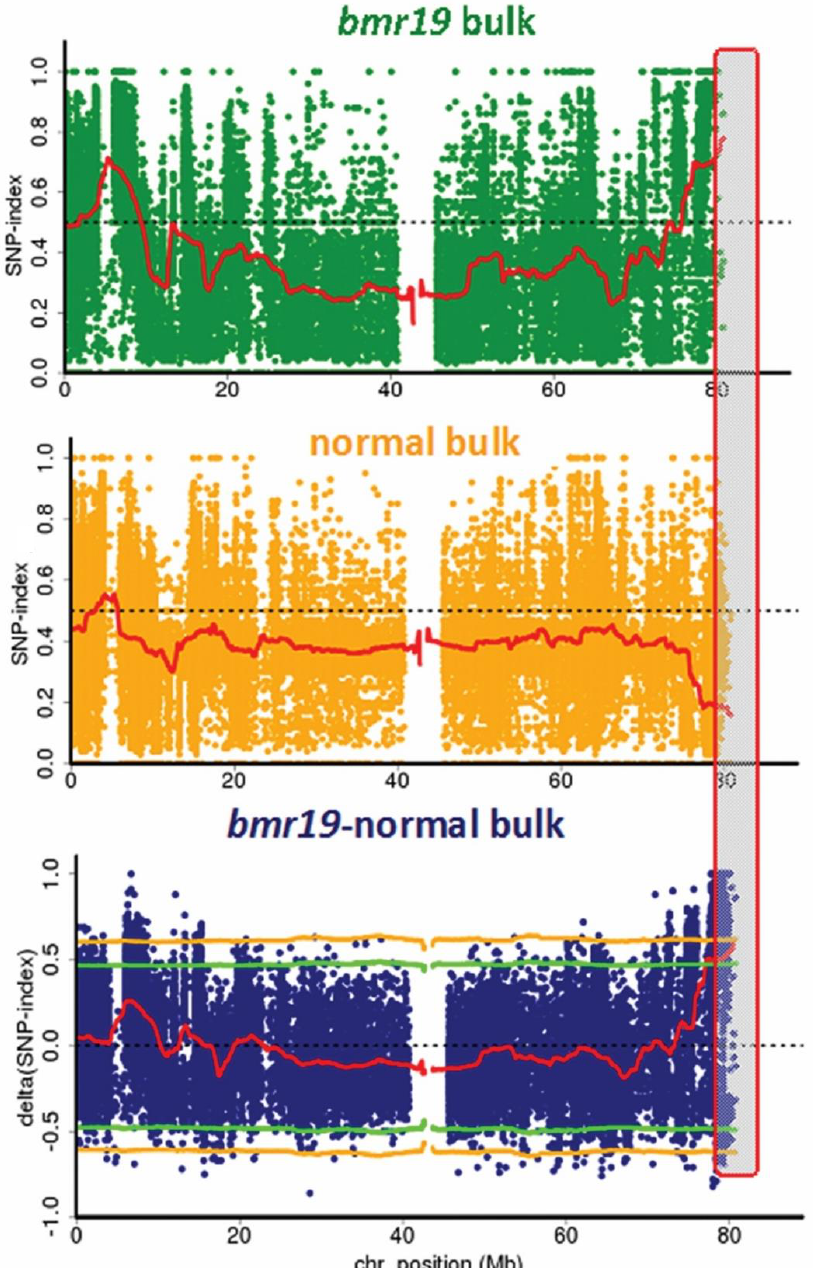
Figure 3. Single nucleotide polymorphism (SNP) analysis to identify bmr19 mutation. SNP index plots of bmr19 bulk ( top ), normal bulk ( middle ) and Δ(SNP-index) plot ( bottom ) of sorghum Chromosome 1 with statistical confidence intervals of bmr19 bulk ( top ), normal bulk ( middle ) and ∆ (SNP-index) plot ( bottom ) of sorghum Chromosome under the null hypothesis of no QTLs (green, p < 0.05; yellow, p < 0.01). Grey highlighted area shows the QTL at the end 1 with statistical confidence intervals under the null hypothesis of no QTLs (green, p < 0.05; yellow, of Chromosome 1 where the significant difference between the bulks occurs. p < 0.01). Grey highlighted area shows the QTL at the end of Chromosome 1 where the significant difference between the bulks